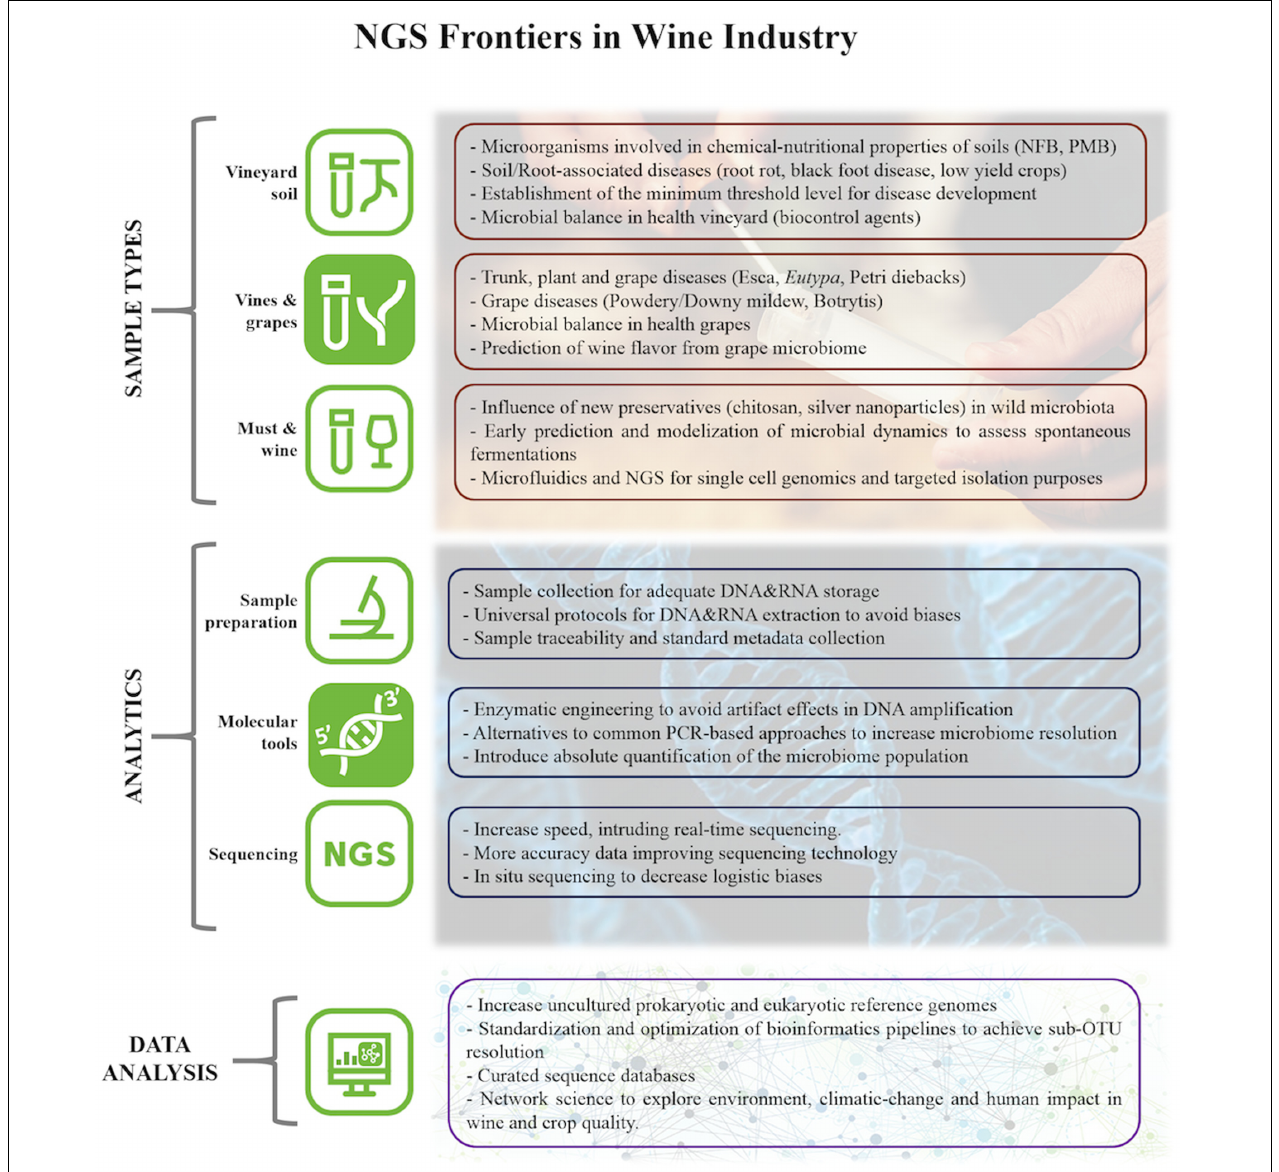
FIGURE 1 | Current challenges on viticulture and enology assumable by NGS approaches; advisable technical improvements; necessities and perspectives in data science. NFB means ‘Nitrogen Fixing Bacteria’ and PMB means ‘Phosphate Mobilizing